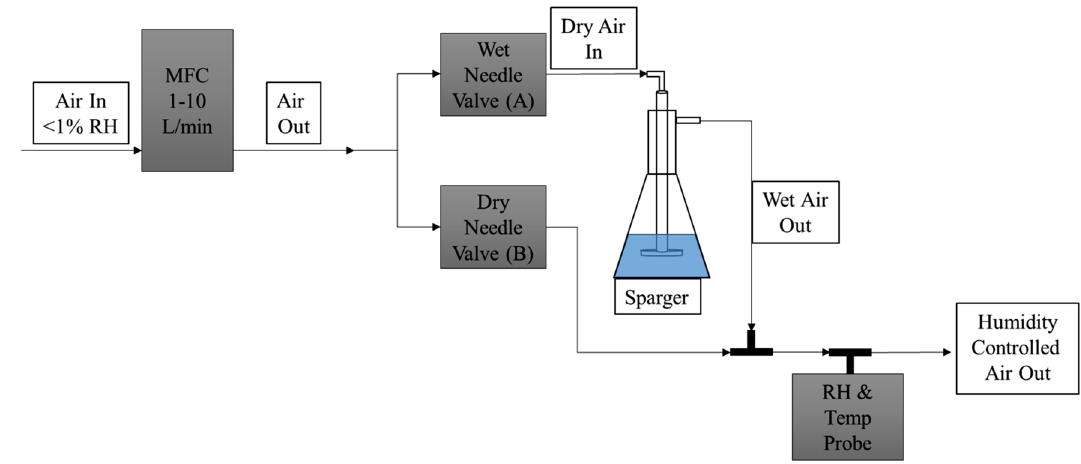
Figure 2. Humidity generator/controller